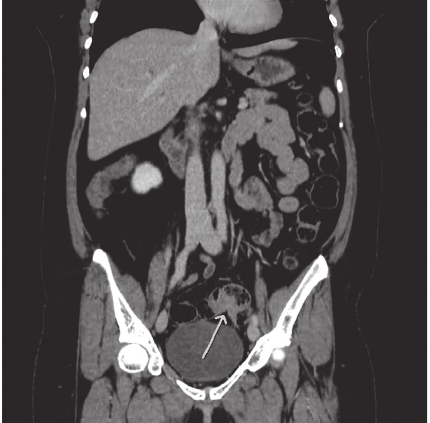
Figure 2: Coronal image of abdomen tomography with stenosing lesions in sigmoid presenting impregnation with contrast, as shown by the pointing arrow.